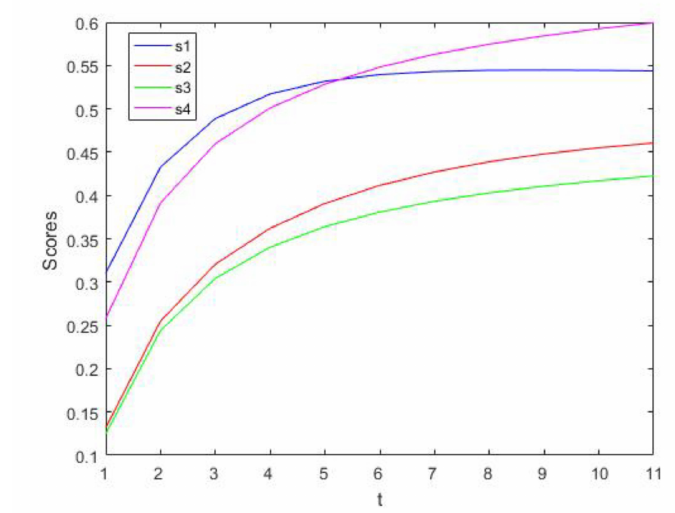
Figure 1. s = 1, t ∈ [ 1, 11 ] .